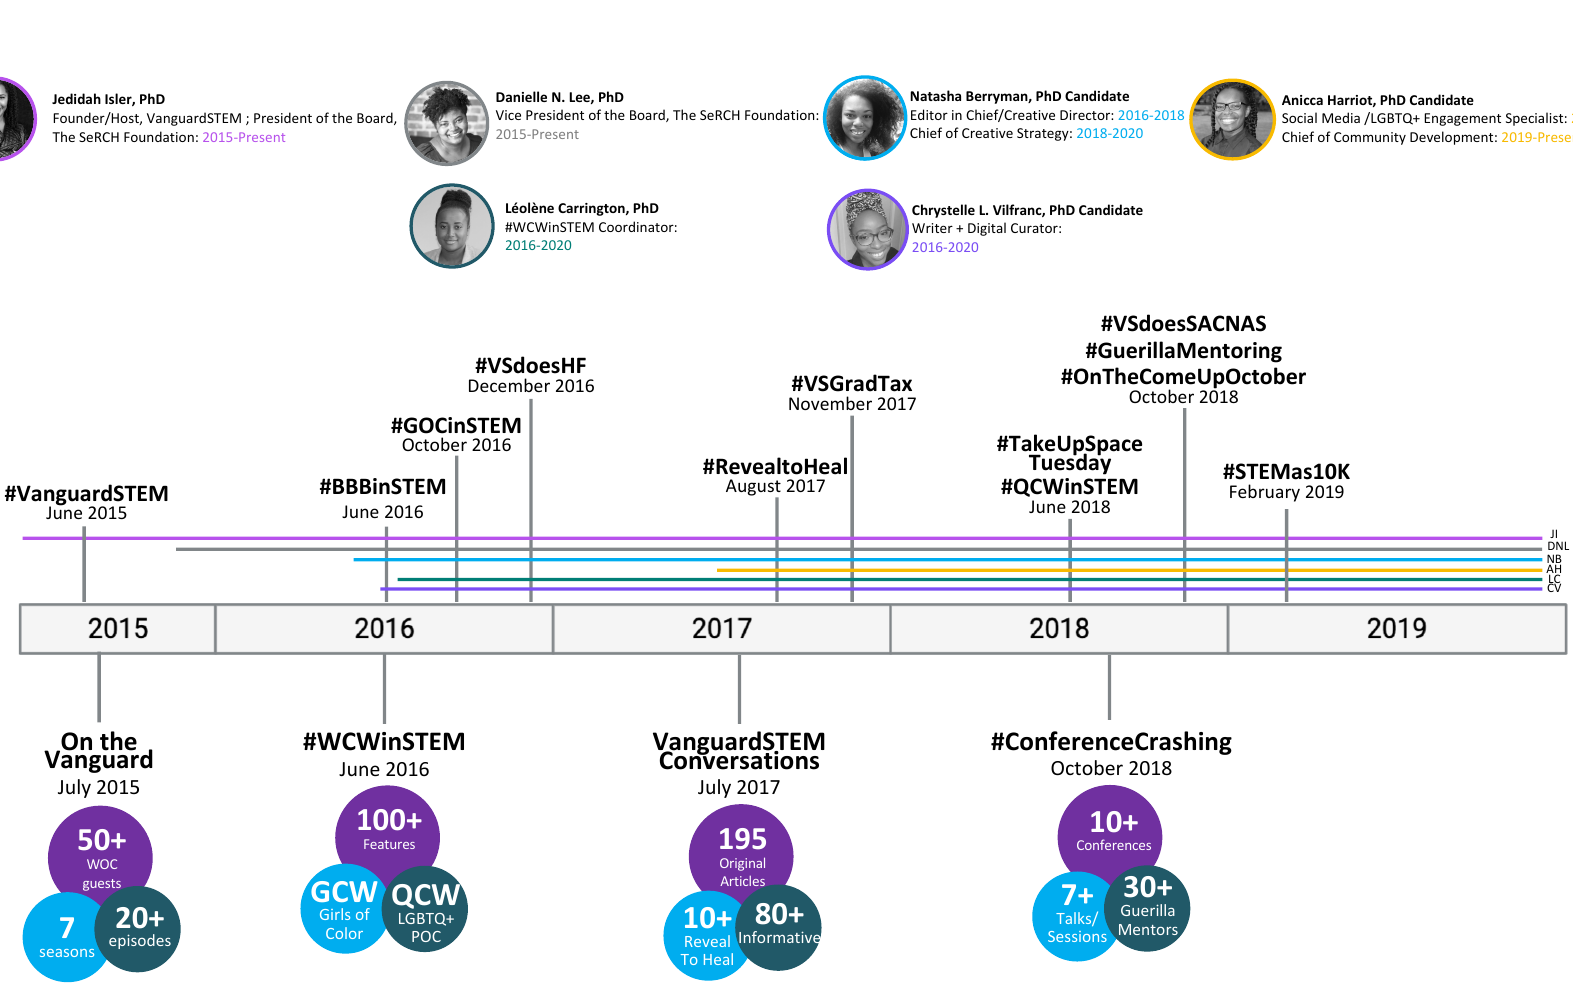
Figure A1. Pictured above are the team of Black women who conceived of and executed a comprehensive set of praxis-driven programming that we believe has changed the digital STEM landscape. #VanguardSTEM is a collaborative effort that has grown and evolved as we brought together our situated knowledges and scientific